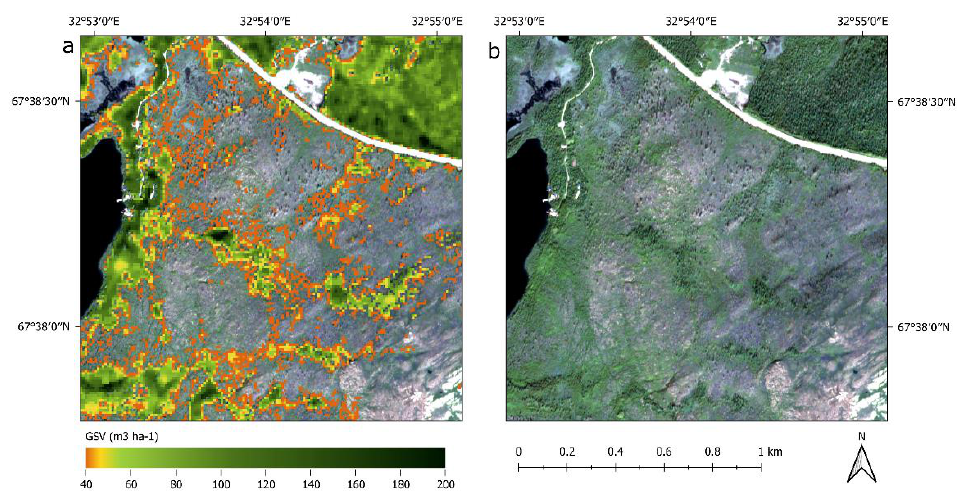
Figure 8. ( a ) Extract of modelled GSV product from the Khibiny study area; ( b ) corresponding Figure 8. (a) Extract of modelled GSV product from the Khibiny study area; (b) corresponding WorldView 2 true colour composite. WorldView 2 true colour composite.